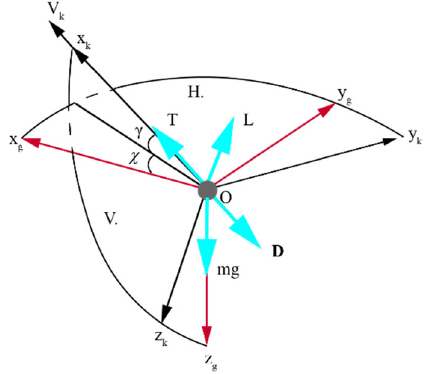
Figure 6. Coordinate system definition in flight tests.